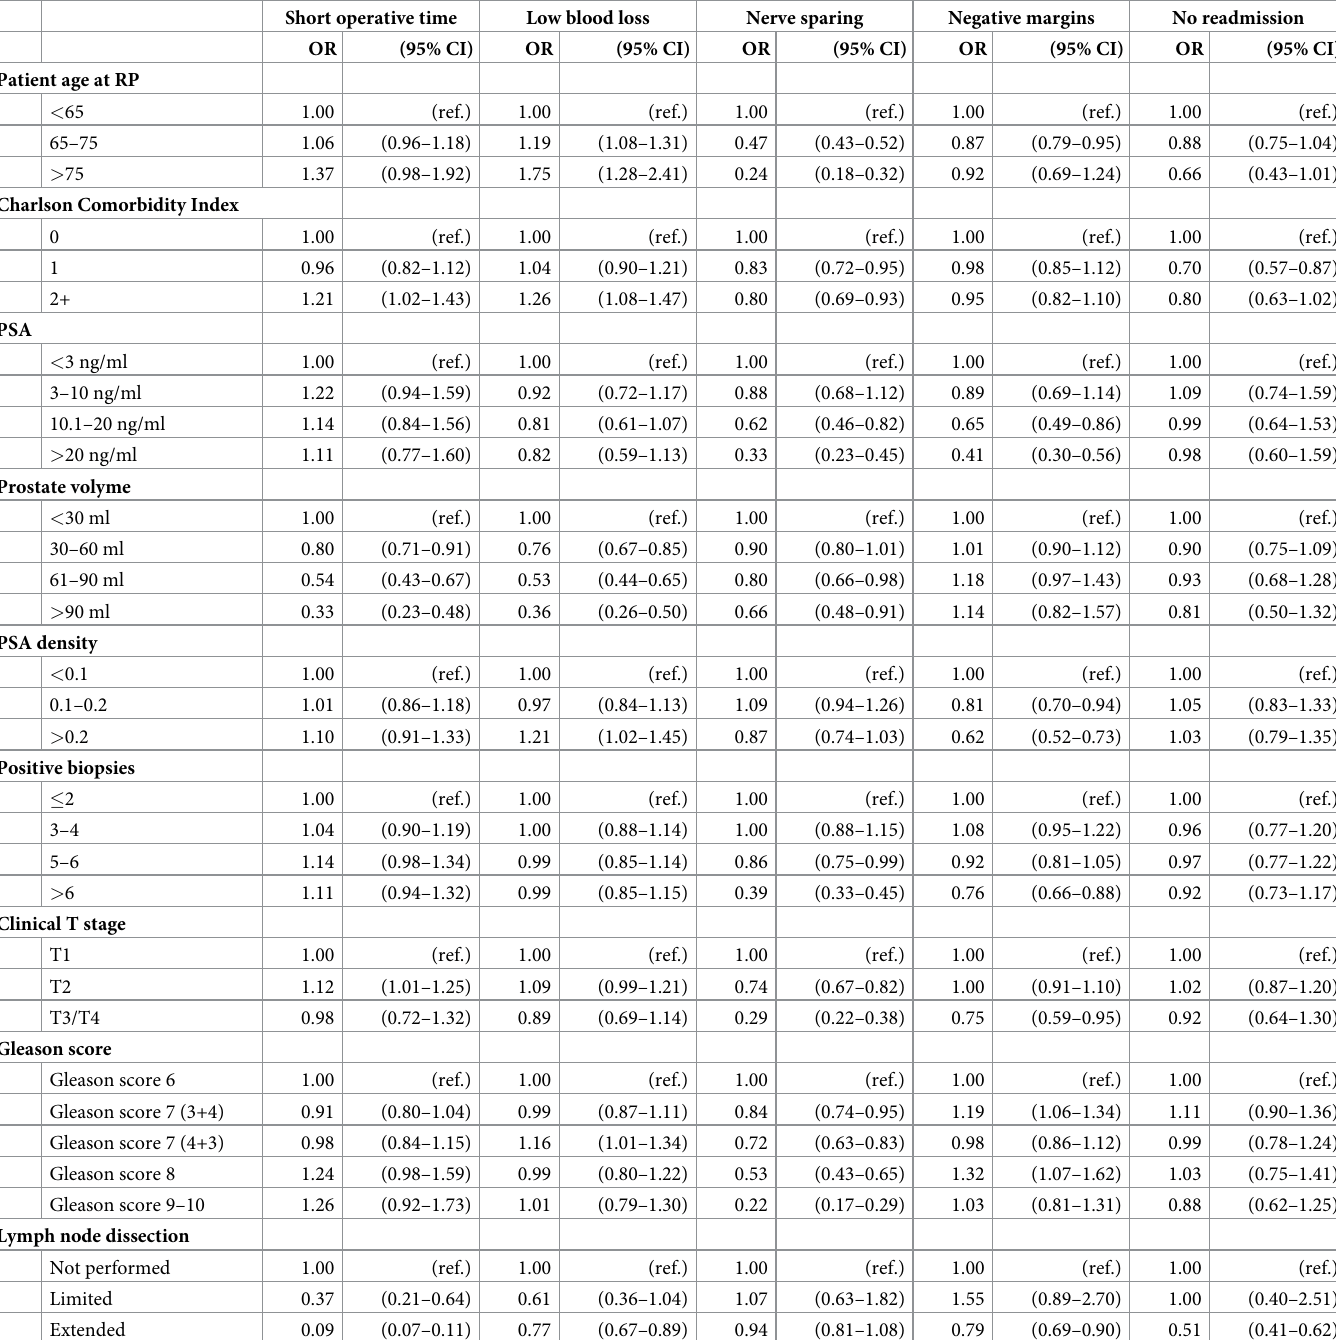
Table 2. Odds ratios (OR) and 95% confidence intervals (CI) of the covariates for respective outcome according to surgical volume by single